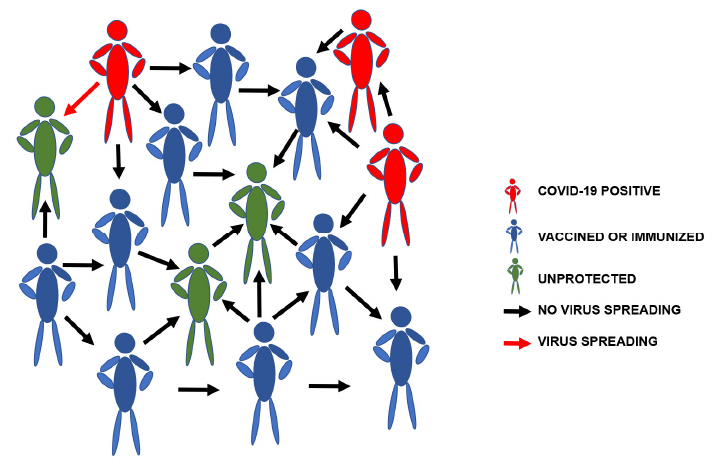
Figure 2. Herd immunity for the spread of severe acute respiratory syndrome coronavirus 2 (SARS-CoV-2).